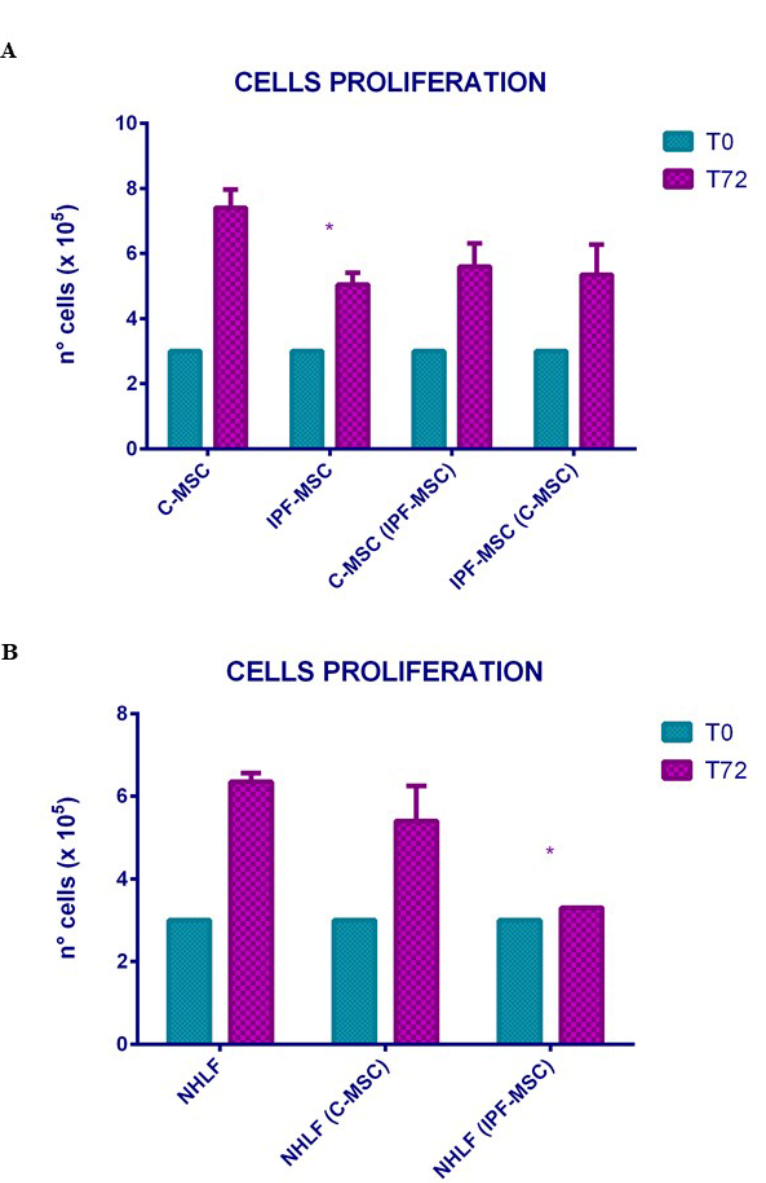
Figure 4. E ff ect of co-cultures on cellular proliferation. The histogram ( A ) indicates the proliferation of mesenchymal stem cells (MSCs) derived from control (C-MSCs) and idiopathic pulmonary fibrosis (IPF-MSCs) tissues (cultured alone) or co-cultured. C-MSCs: MSCs from controls cultured alone; IPF-MSCs: MSCs from patients with IPF cultured alone; C-MSC (IPF-MSCs): C-MSCs after 72 h of co-culture with IPF; IPF-MSCs (C-MSCs): IPF-MSCs after 72 h of co-culture with C-MSCs. The * indicate significative di ff erences referred to C-MSC (one-way ANOVA; p < 0.05). Histogram ( B ) depicts the proliferation of NHLF cultured alone or co-cultured with C-MSCs (NHLF (C-MSCs)) or with IPF (NHLF (IPF-MSCs)) for 72 h *: p < 0.05 NHLF (IPF-MSCs) vs. NHLF. (The * indicate significative di ff erences referred to C-MSC (two-way ANOVA; p <